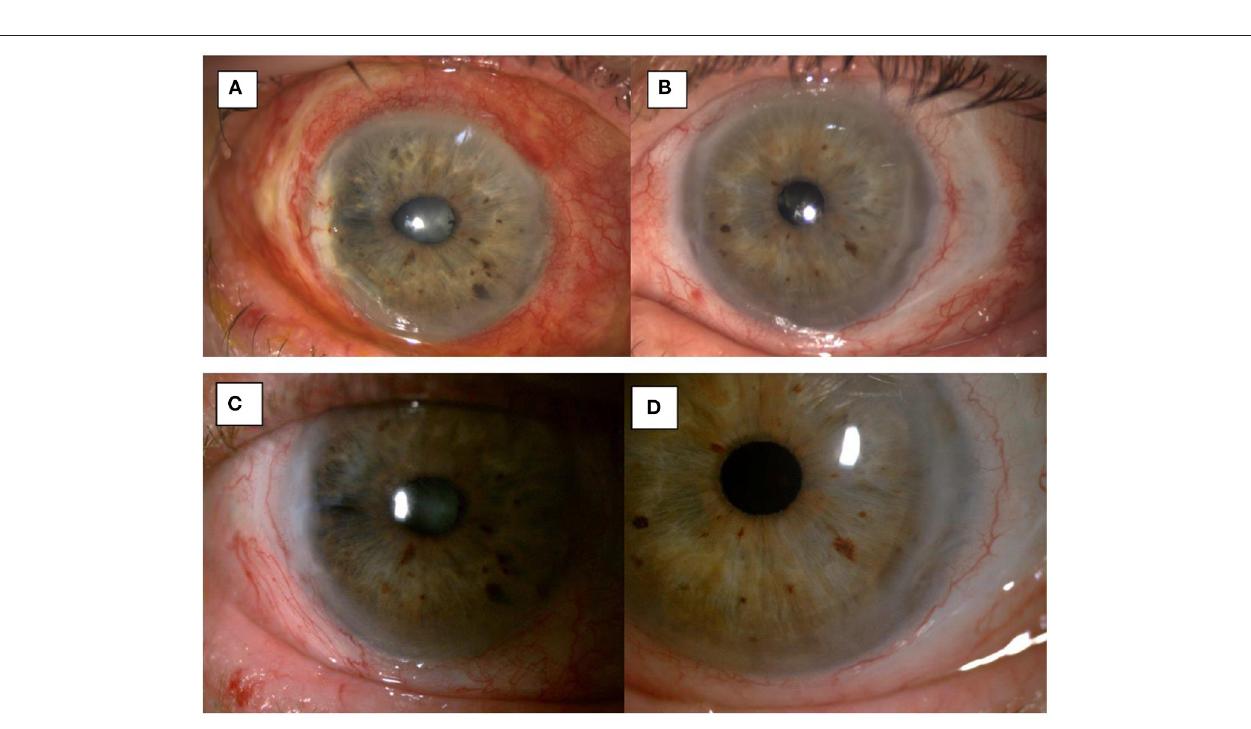
FIGURE 4 | 1-month post-op image showing integration of the amniotic membrane patch in the temporal corneal stroma of the right eye (A) and the left eye (B) . 3-month post-op image showing uninflamed eyes and a smooth integration of the amniotic membrane patch in the temporal corneal stroma of the right eye (C) and the left eye (D)